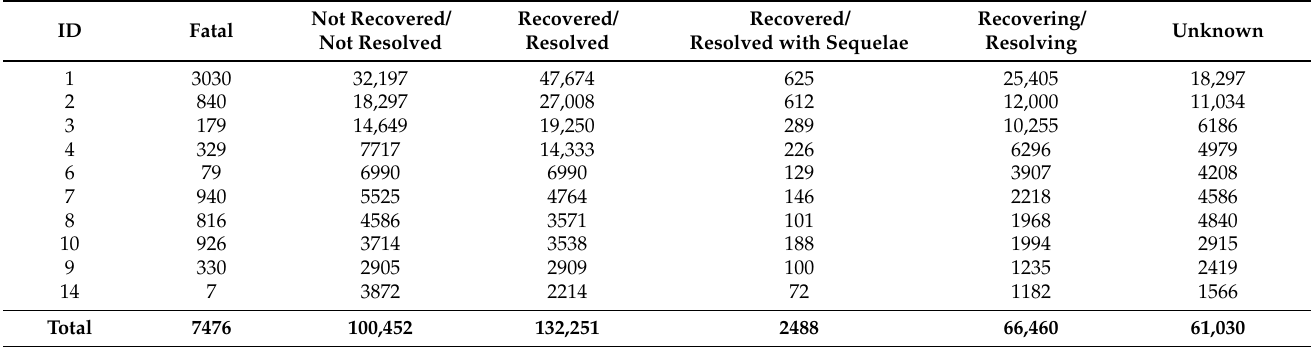
Table 3. Outcome of reports of suspected major adverse events related to Spikevax vaccine after 63 million doses administered